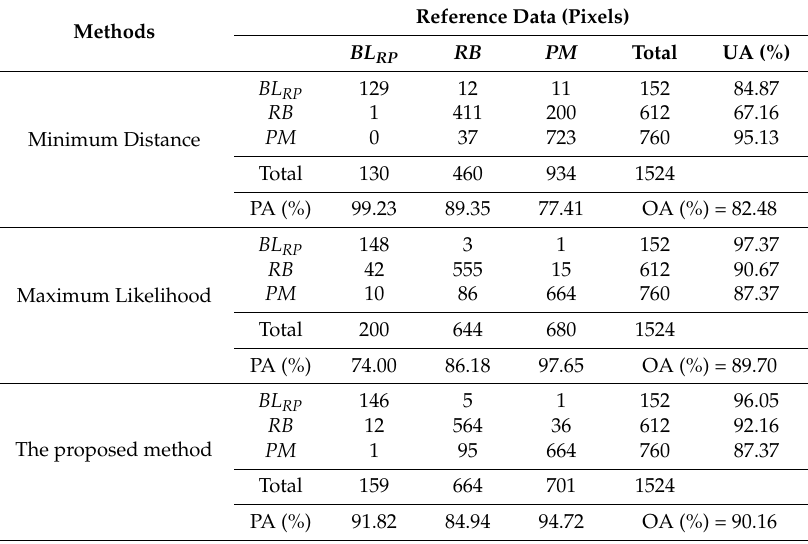
Table 6. The error matrix of three classification